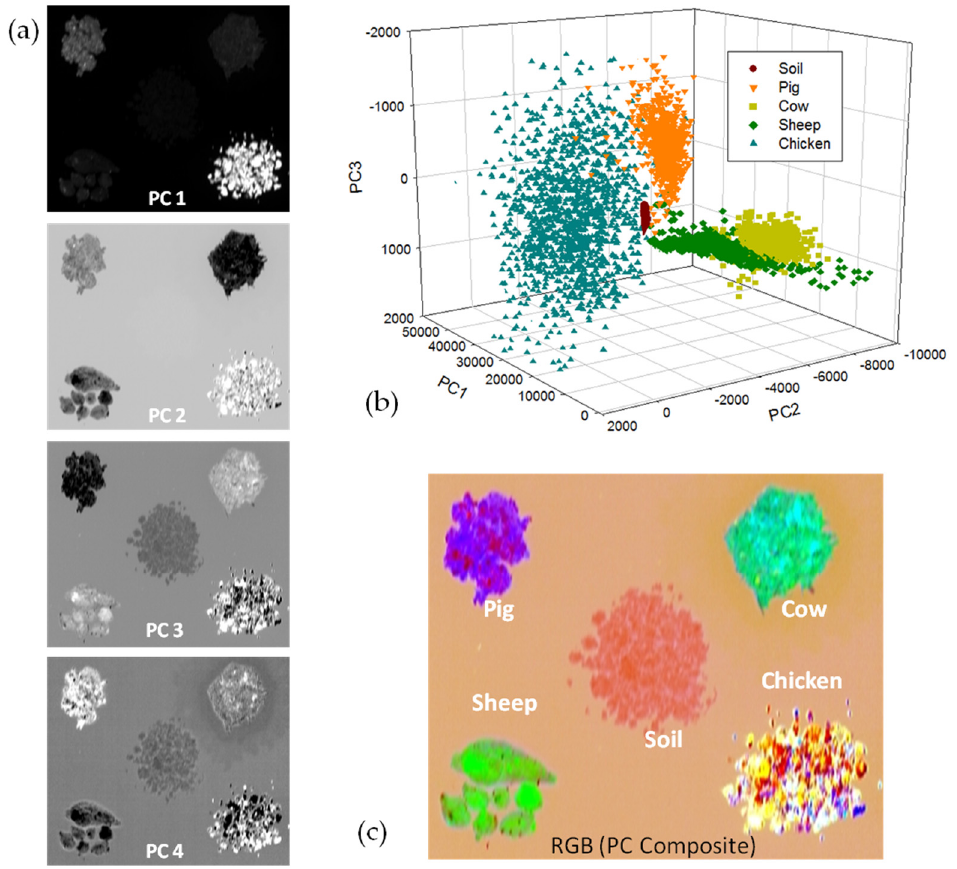
Figure 3. ( a ) First to fourth principal component (PC) score images of animal feces and soil samples; ( b ) Scatter plot of individual feces and soil samples pixels in PC1, PC2, and PC3 domains; ( c ) RGB color composite image obtained from a combination of PC2, PC3, and PC4 score images.